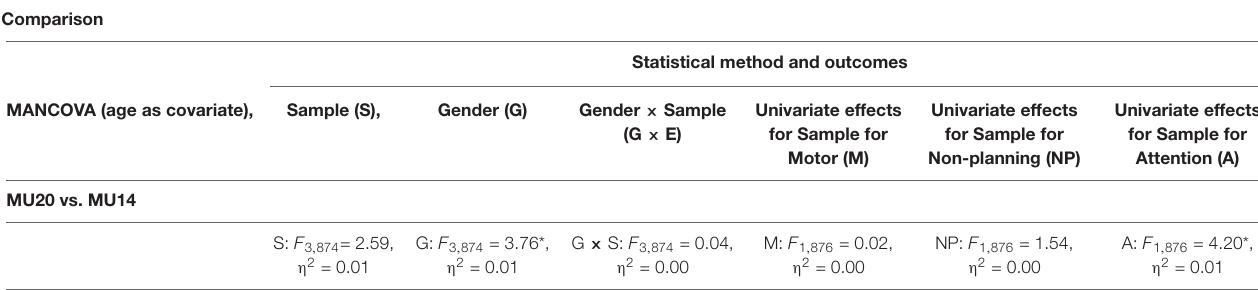
Statistical method and outcomes Univariate effects Univariate effects Univariate effects (G × E) for Sample for for Sample for for Sample for Motor (M) Non-planning (NP) Attention (A)